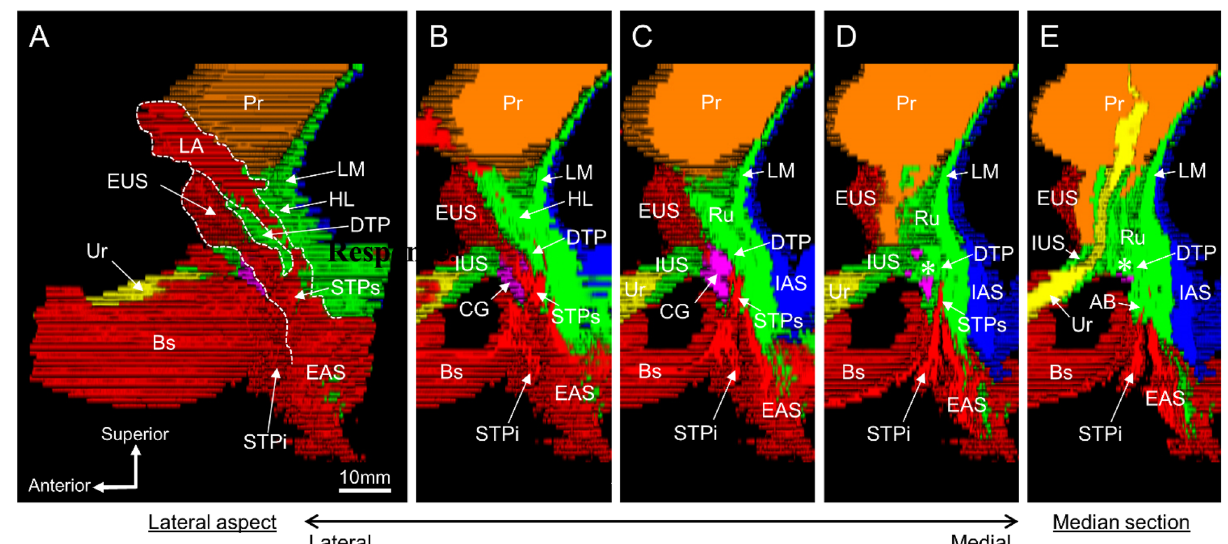
Figure 7. Three-dimensional reconstruction images showing the lateral aspect and sagittal sections. ( A ) The lateral aspect from left side. The LA, EAS, and STPs merged and extended anteriorly, forming the EUS on the lateral and anterior sides of the Ur. ( B ) A sagittal section lateral to the CG. The STPs was observed to cover the lateral side of the CG. The STPi was continuous with the Bs. ( C ) A sagittal section through the CG. The